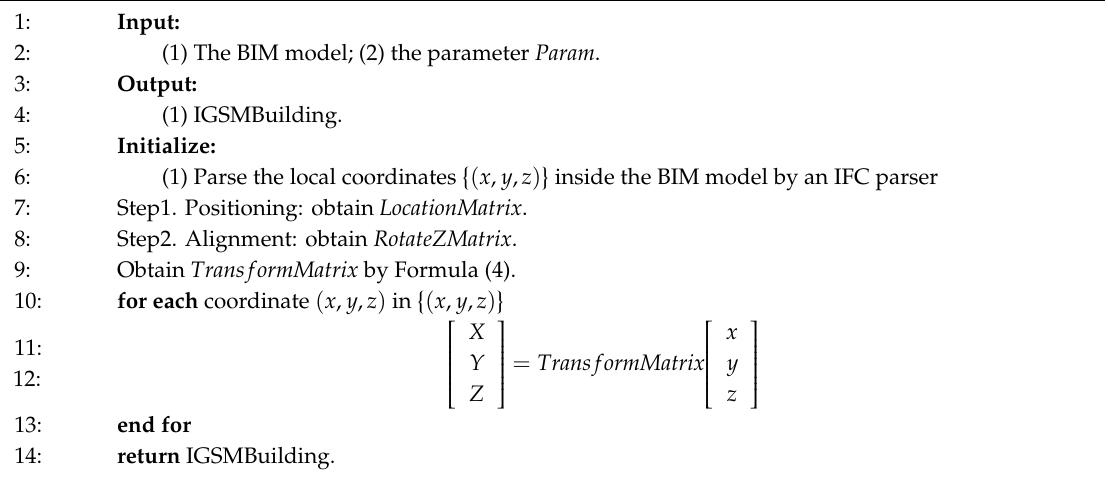
Algorithm 1. Geographic Location Mapping